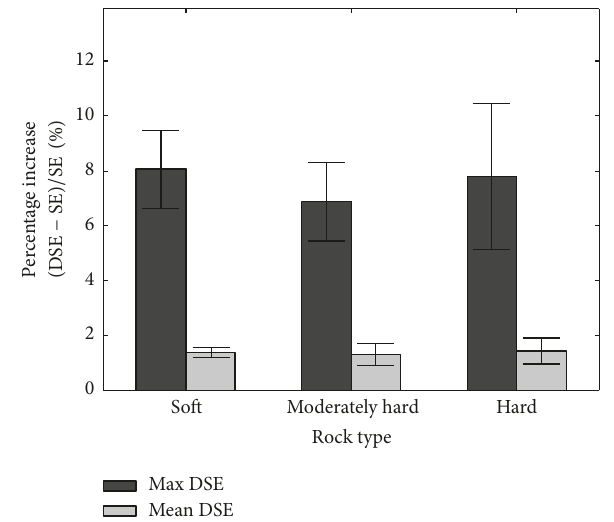
Figure 7: Percentage increases of maximum DSE and mean of DSE relative to